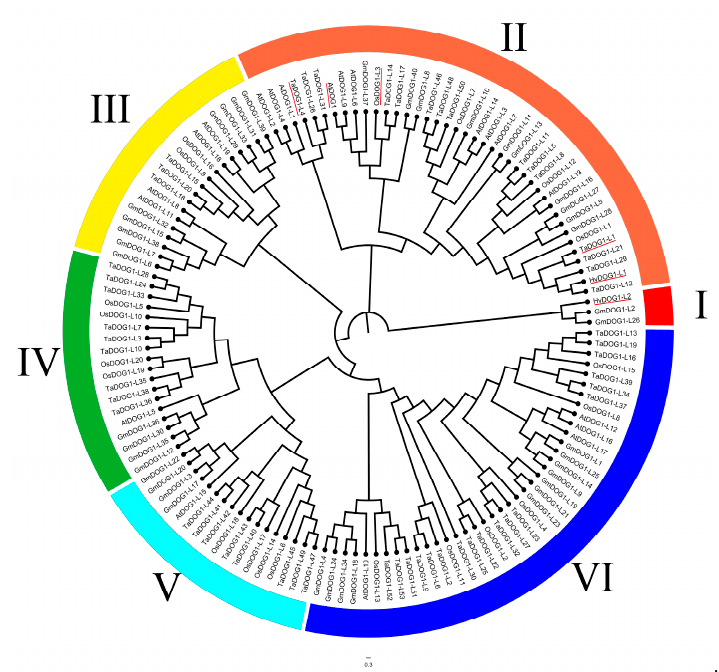
Figure 1. Phylogenetic analysis of DOG1Ls from Glycine max , Arabidopsis, Hordeum vulgare , Triticum aestivum and Oryza sativa . DOG1-like genes for which a seed dormancy function has been confirmed are red underlined. Clustal W software was used to align 135 DOG1Ls . A maximum likelihood phylogenetic tree was constructed by MEGA7.0 software with the Poisson model and 1000 bootstrap replications. The group I–VI use di ff erent color di ff erence between